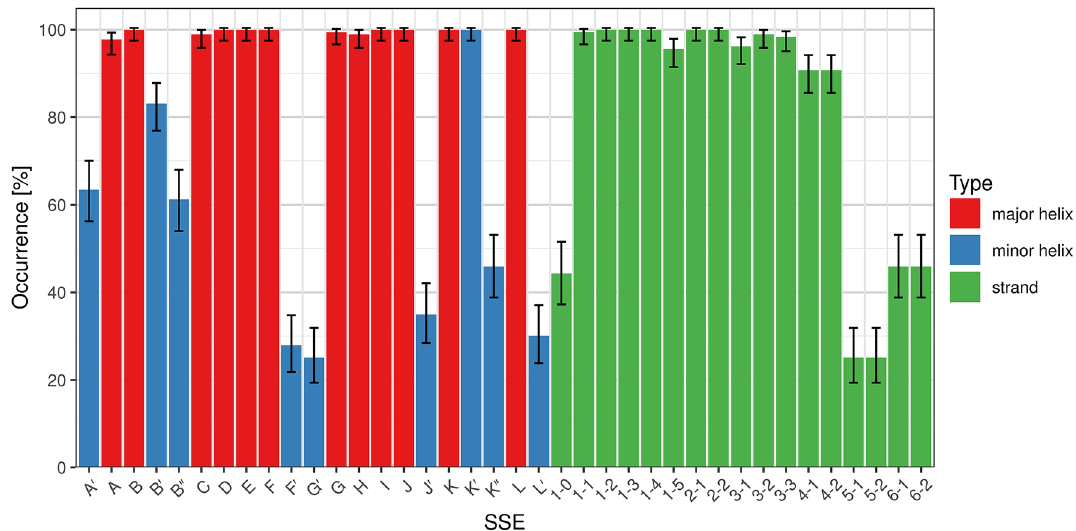
Figure 2. Frequency of occurrence of individual SSE classes. Error bars show confidence intervals calculated by the Agresti-Coull method for α = 0.05 36 .